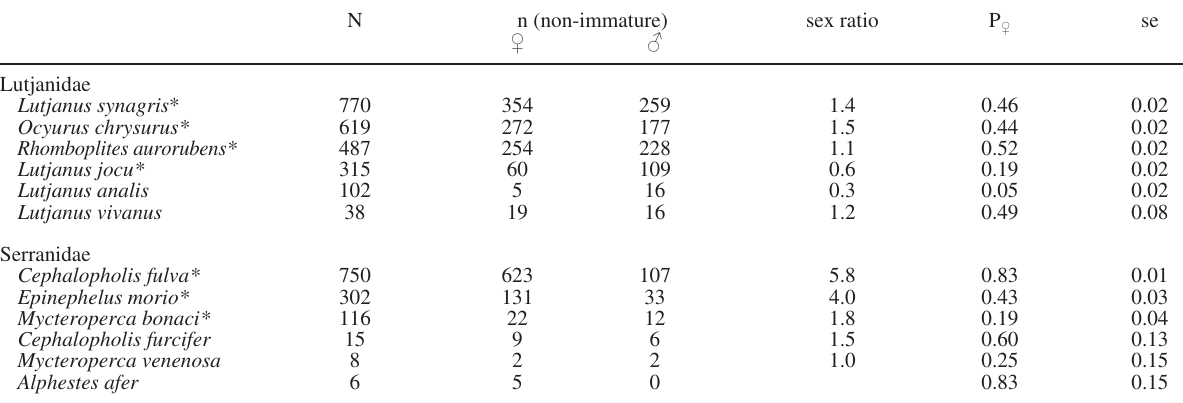
Table 1. – Total sample size, number of non-immature individuals in the sample, and sex ratio for the most frequent species of snapper (Lutjanidae) and groupers (Serranidae) in the Abrolhos Bank reef fisheries. The * indicates species included in the GSI analyses. p refers to ♀ the proportion of females, se is the standard error of p ♀ .